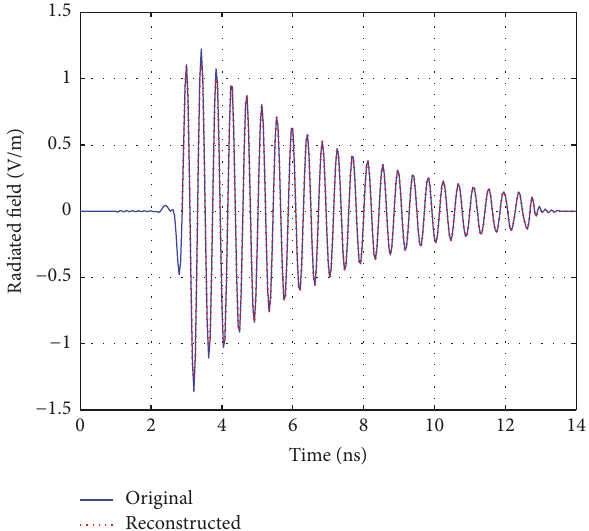
Figure 22: Comparison of original impulse response and the reconstructed response of the microstrip antenna.